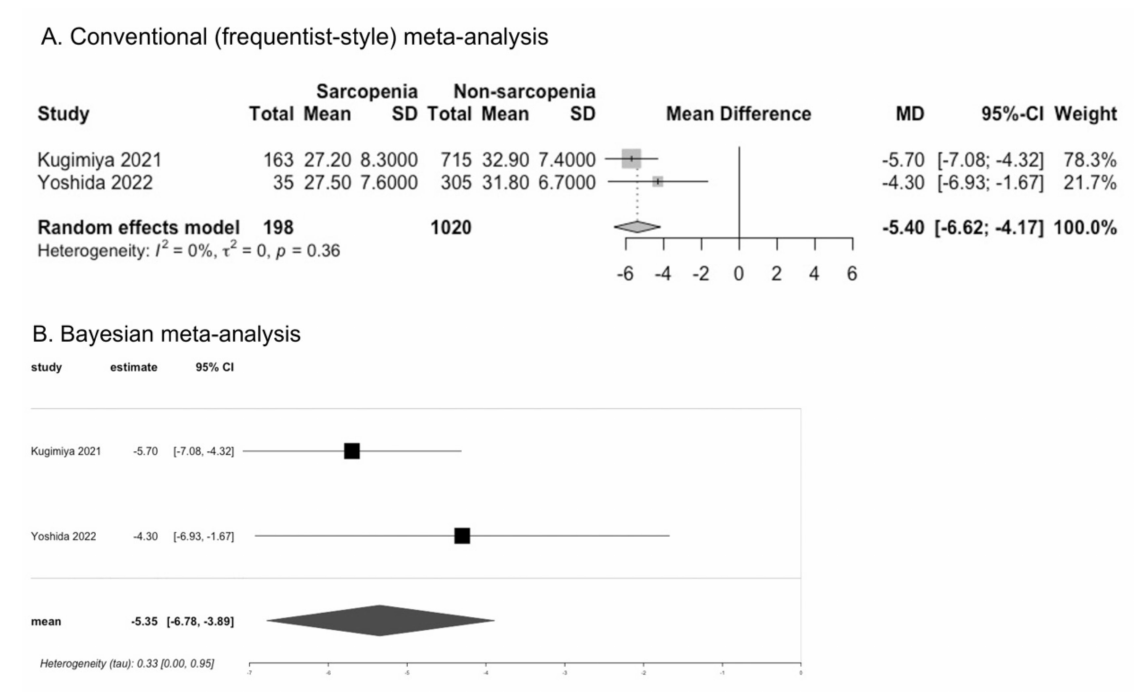
Figure 2. Comparison of tongue pressure between individuals with and without sarcopenia [20,25].